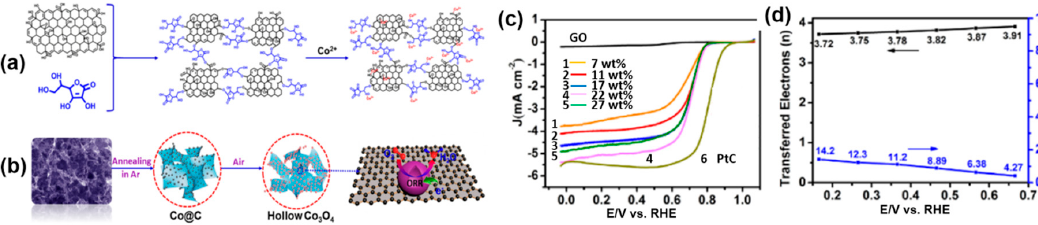
Figure 7. ( a ) Schematic representation of how an excess of ascorbic acid reduced graphene oxide (GO) and formed 3DG (three-dimensional graphene). The added Co 2+ are anchored on 3DG; ( b ) Schematic showing the formation of HNPs (hollow nanoparticles) Co 3 O 4 /3DG material; ( c ) LSVs (cathodic sweep) curves of GO, Co 3 O 4 /3DG (with various weight loading) and Pt/C electrodes in O 2 -saturated 0.1 M KOH electrolyte at 5 mV s − 1 at 1600 rpm; ( d ) the transferred electrons and peroxide percentage of Co 3 O 4 /3DG (22 wt%). Reproduced from [81], Copyright © Wiley, 2017.